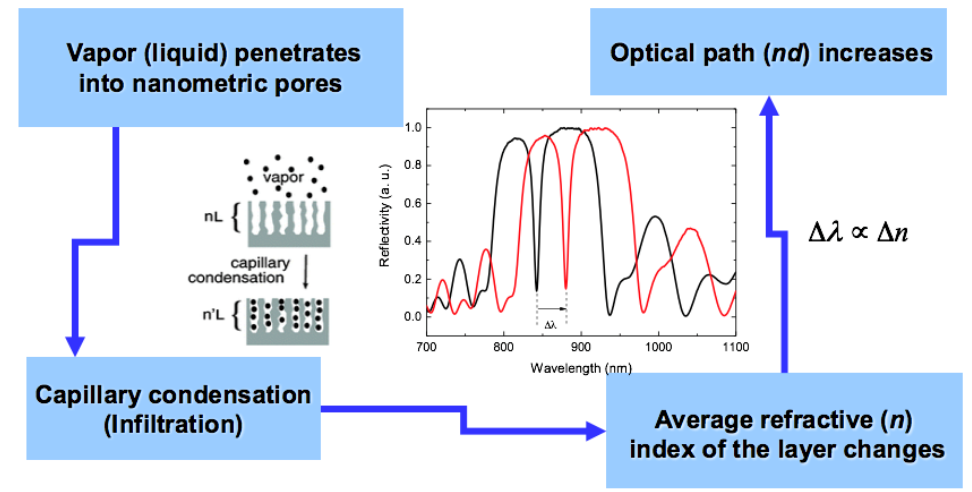
Figure 1. Schematic representation of PSi sensing mechanism based on the variation of the average refractive index.